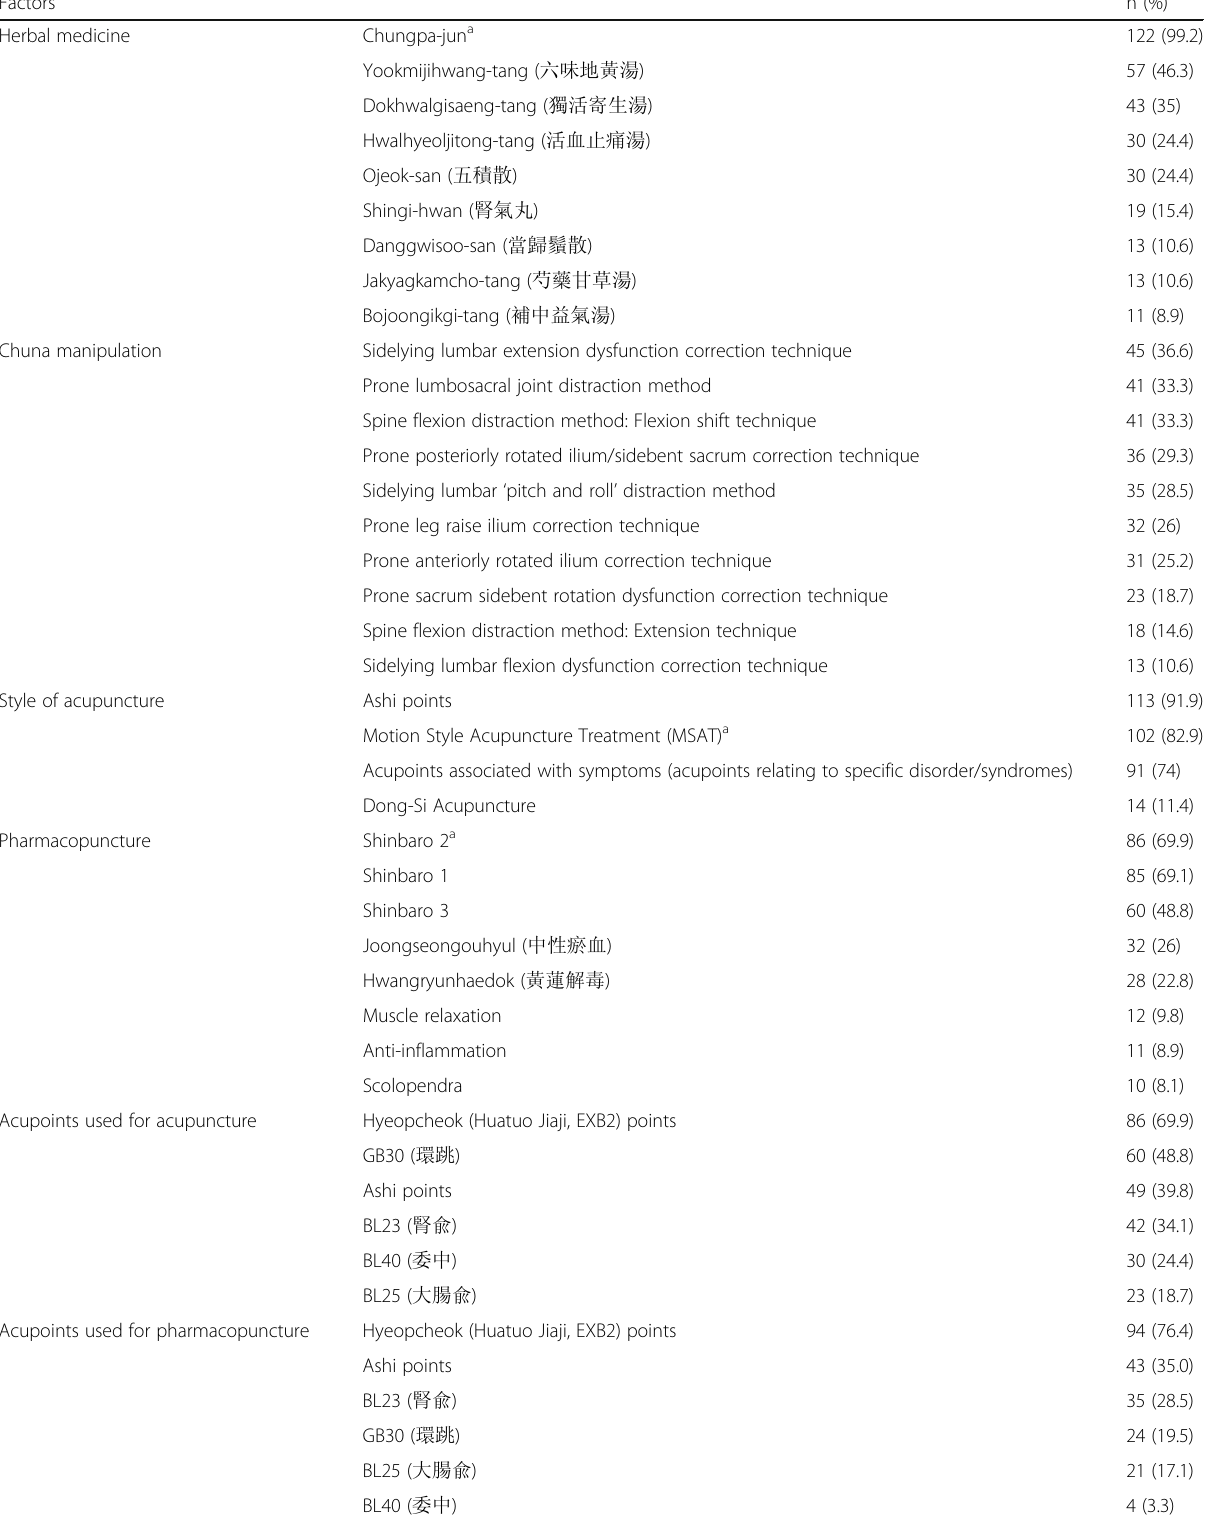
Table 6 Commonly used Korean medicine treatments for LSS